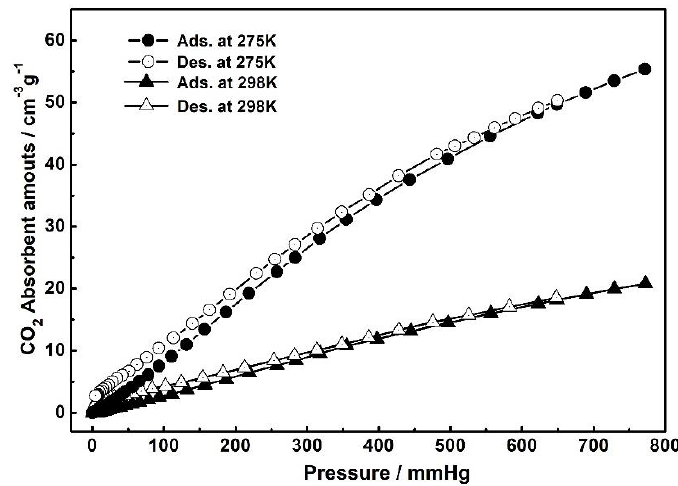
Figure 4. Gas sorption isotherms of 1 of CO 2 measured at 275 and 298 K, respectively. Filled shape, adsorption; open shape, desorption.